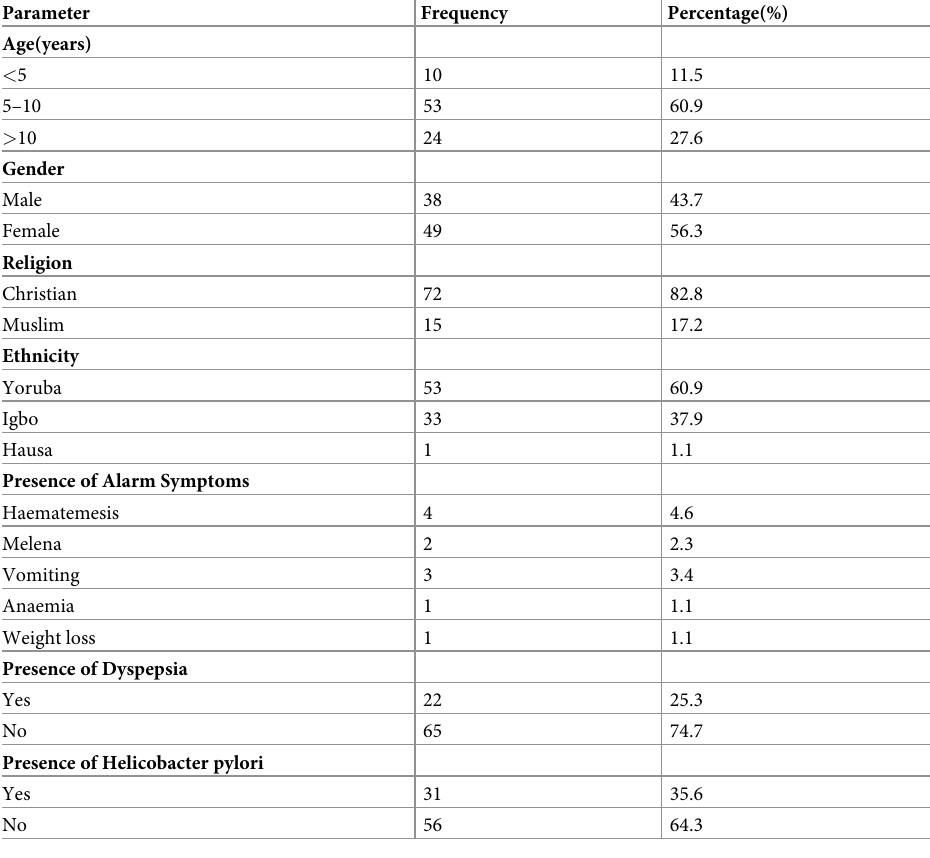
Table 1. General characteristics of the study